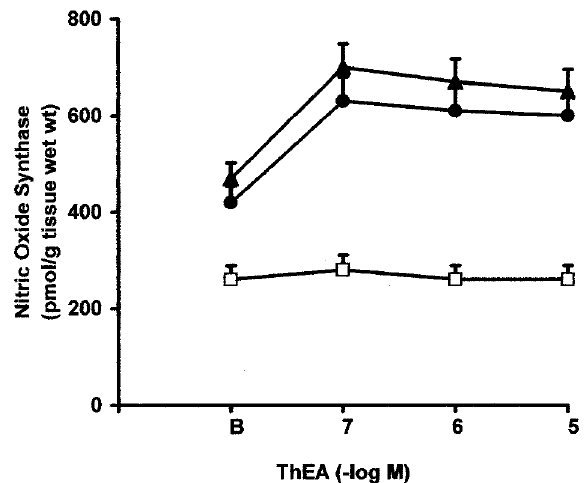
FIG. 3. ThEA action on NOS activity. Rat submandibular gland slices were incubated with different concentrations of the H 1 receptor agonist ThEA in the absence ( d ) or the presence ( m ) of the NOS inhibitor L -NMMA (5 ´ 10 –5 M). Reversal of inhibition by a natural NOS substrate L -arginine (5 ´ 10 –4 M) ( h ) and basal values (B) are shown. Values presented as the mean ± SEM of eight experiments per- formed in